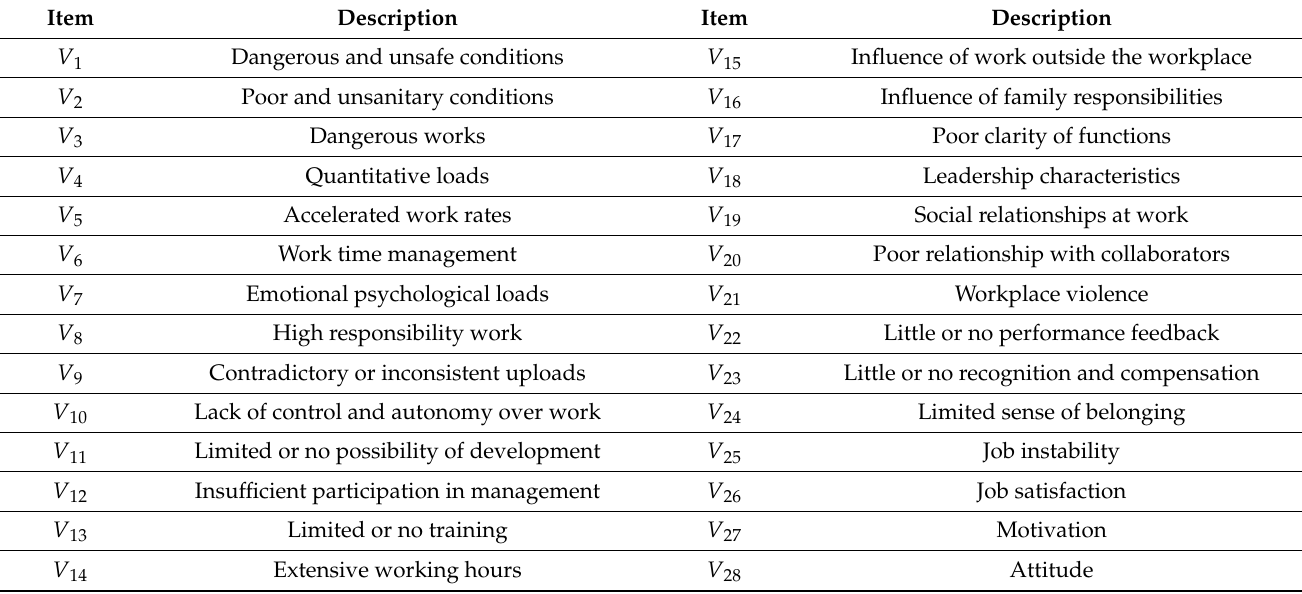
Table 5. NOM-03 risk